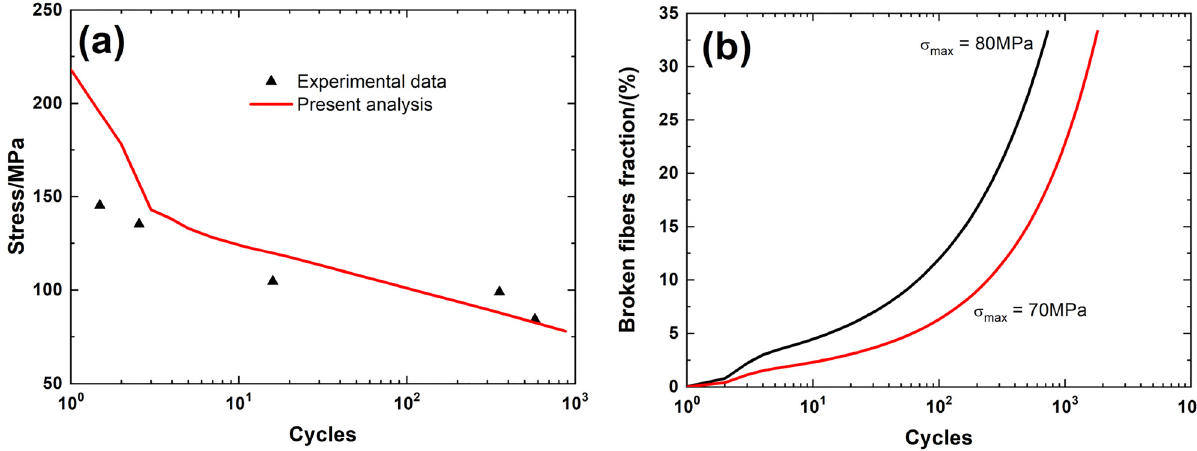
Figure 5: ( a ) Experimental and predicted fatigue life S – N curves, and ( b ) the FBFF versus applied cycles of cross - ply SiC/MAS composite under IP - TMF loading.